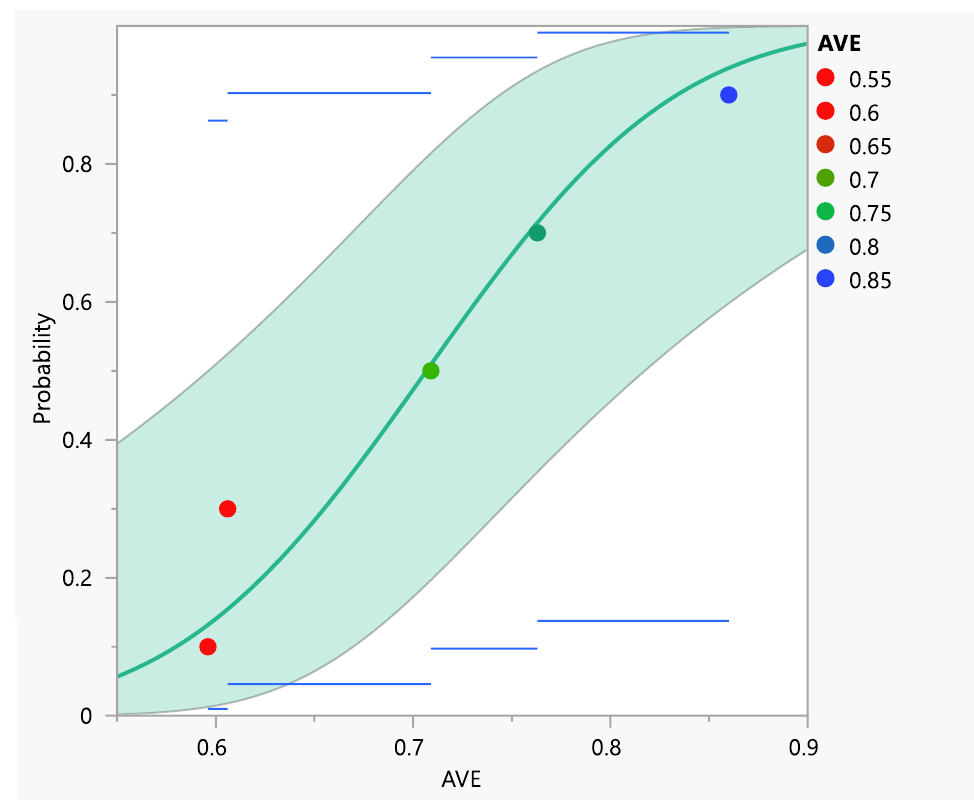
Figure 7. Normal probability curve of AVE. Table 6. Fornell larker criterion for discriminant